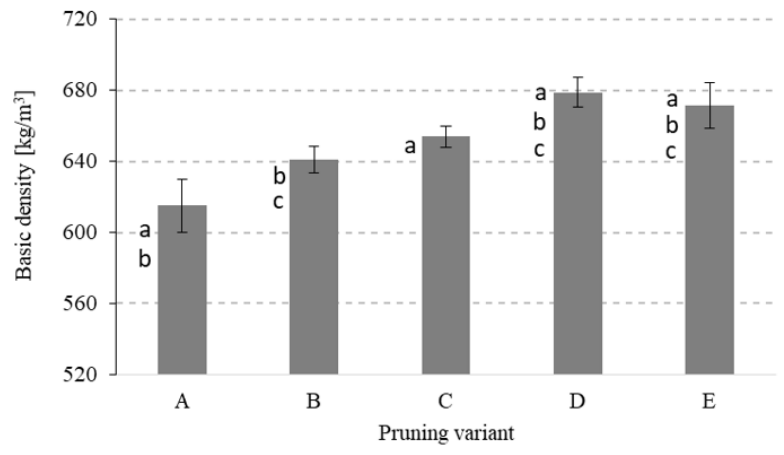
Figure 6. Mean wood density of the pine depending on the pruning variant. a, b, and c indicate statistically significant differences at the level of p ≤ 0.05.